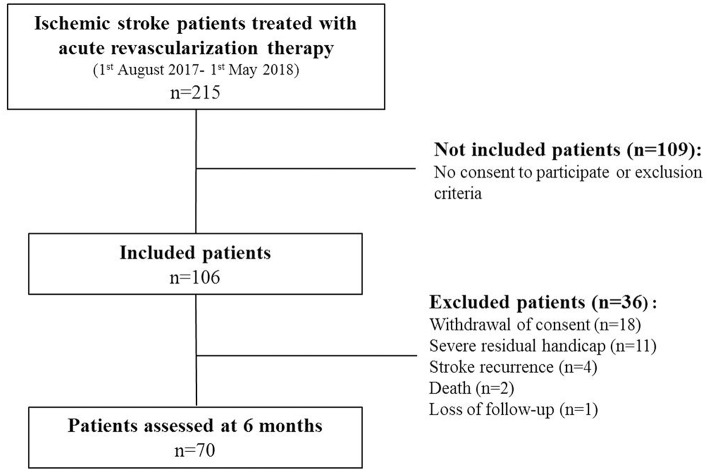
Flowchart of the study.